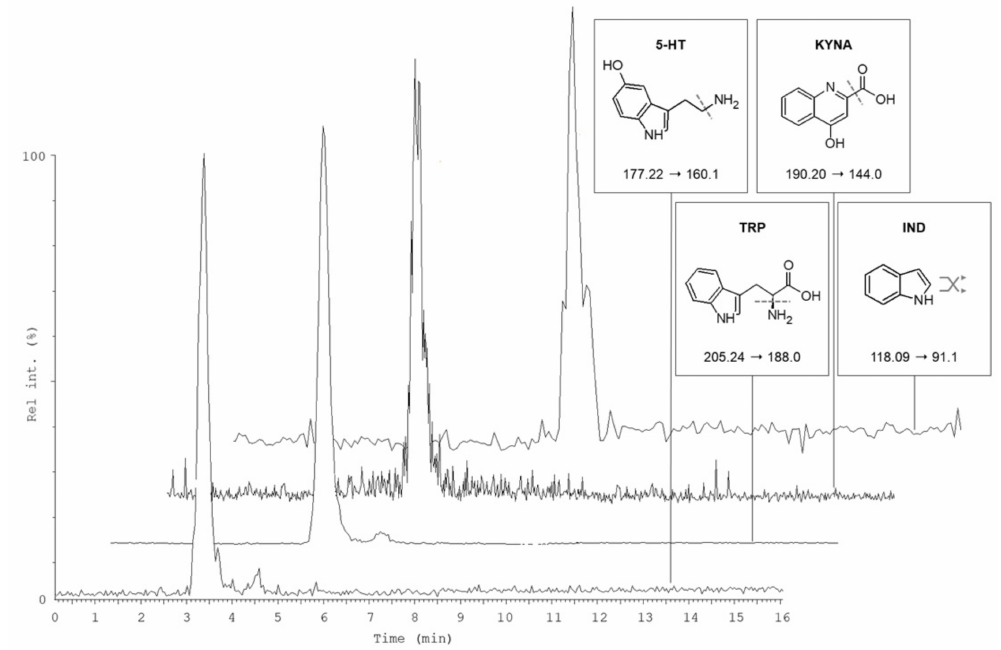
Figure 3. LC-MS/MS chromatogram of a whole blood VAMS sample from a mouse (female). The fig- ure shows a selection of four representative MRM channels: 5-HT (189 ng/mL), TRP (6544 ng/mL), KYNA (9.4 ng/mL) and IND (1.2 ng/mL). Table 4. Results from VAMS-LC-MS/MS analysis on real